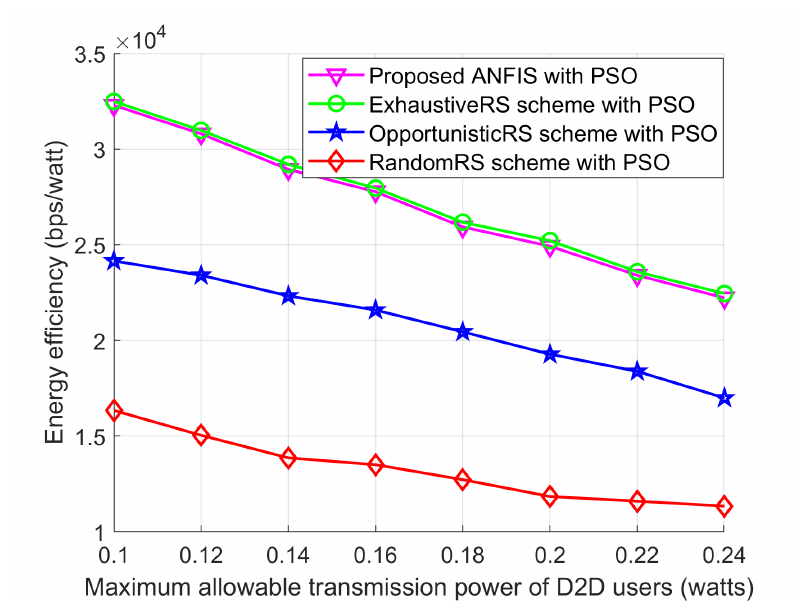
Figure 11. EE performance with P Max .